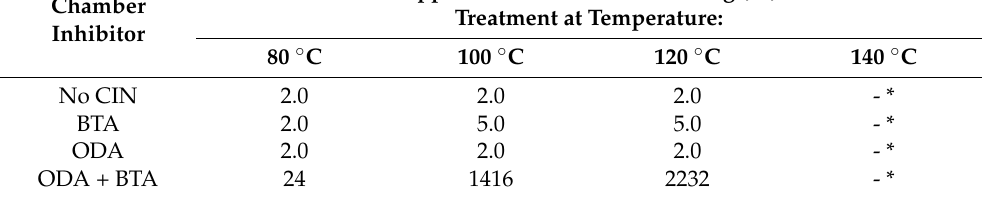
Table 8. Protective aftereffect of adsorption films formed upon brass treatment in CIN vapors at various temperatures. Recurrent moisture condensation conditions. τ CT = 60 min.